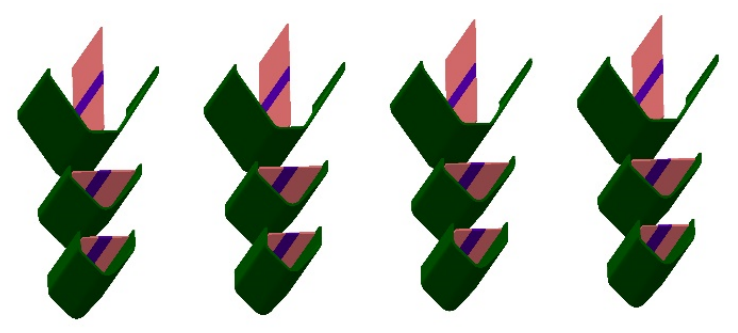
Figure 2. Diagram of the cryosorption pump module.